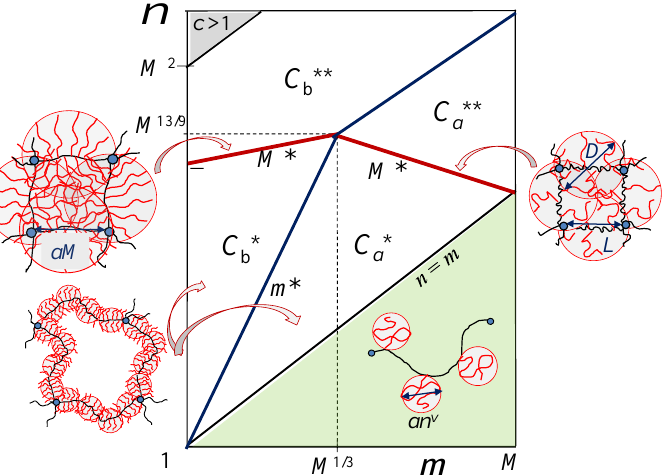
n , m Figure 2. Scaling-type diagram of states for hairy gel in coordinates in good solvent ( ν = 3/5). { } In the hollow-mesh regimes C ∗ and C ∗ a , bottlebrush strands have either partially or almost fully b stretched spacers, respectively. In filled-mesh regimes C ∗∗ and C ∗∗ a , the interior of the gel constitutes b a semi-dilute solution of side chains. Schematics demonstrate strand conformations in regimes C ∗ b C ∗∗ C ∗∗ a (that correspond to backbone length M = M ∗ and C ∗ a , and at boundaries C ∗ and C ∗ a b − b − C ∗ a (marked m ∗ ) at which bottlebrush transforms in starlike polymer with L = D ). Boundary C ∗ b − separates bottlebrush strands with fully ( m < m ∗ ) and partically ( m > m ∗ ) stretched spacers. In the shaded green area, strands are comb-like (side chains are unstretched coils). Strands in regimes of semi-dilute solutions C ∗∗ and C ∗∗ a are shown in Figure b